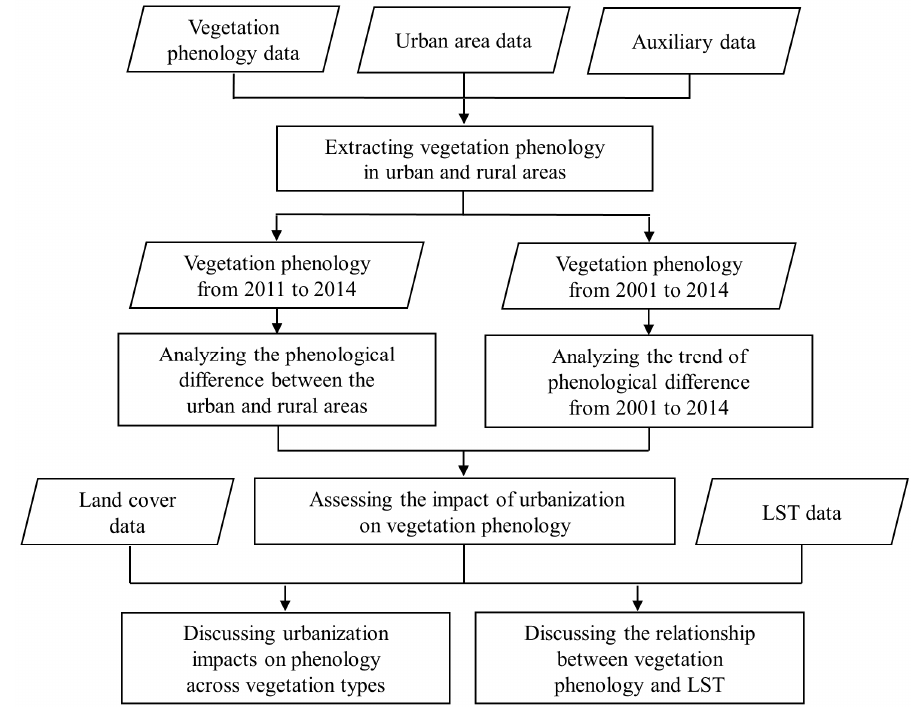
Figure 3. The flow chart of the method proposed in this study.